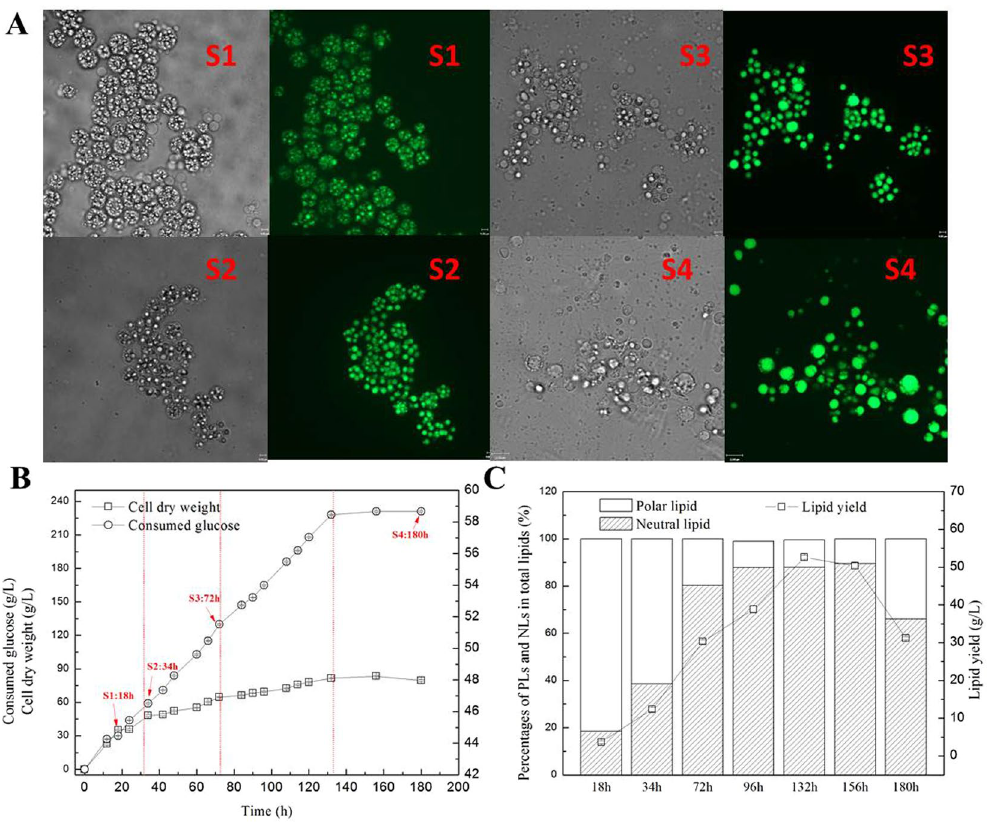
Figure 1. Fermentation characteristic of Schizochytrium sp. HX-308 during lipid accumulation and turnover. ( A ) Cell images of Schizochytrium sp. HX-308 at different cultivation times, ( B ) Cell growth and glucose consumption, including four stage, cell growth stage (S1), lipid early accumulation stage (S2), rapid lipid accumulation stage (S3), lipid turnover stage (S4); ( C ) lipid yield and lipid fractions at different stages. Each datum is the mean value of three identical samples.